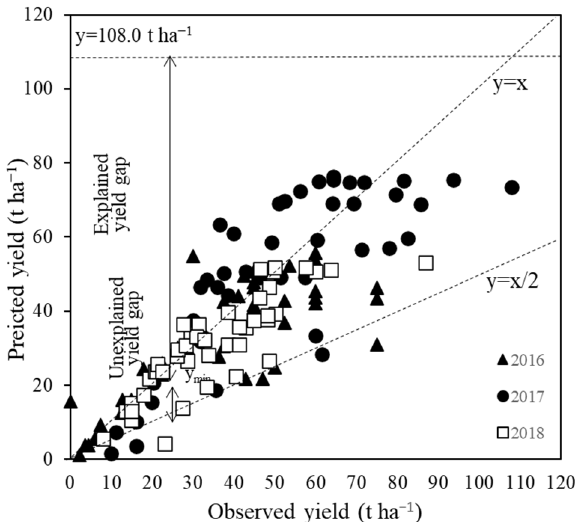
Figure 2. Observed yield against the minimum predicted yield using boundary line analysis during 2016–2018 (n = 45) for Beiquan Village, Hebei, China. The horizontal line y = 108.0 t ha − 1 represents the maximum yield observed in 2017; the maximum yields in 2016 (75 t ha –1 ) and 2018 (87 t ha − 1 ) are not shown. The upper arrow indicates the difference between the minimum predicted yield and maximum attainable yield (defined as the explainable yield gap). The lower arrow indicates the difference between the minimum predicted yield and the observed yield (defined as the unex- plained yield gap) based on production constraints. The dotted diagonal lines representing 1:1 and 2:1 depict the relationships y = x and y = x/2, respectively.